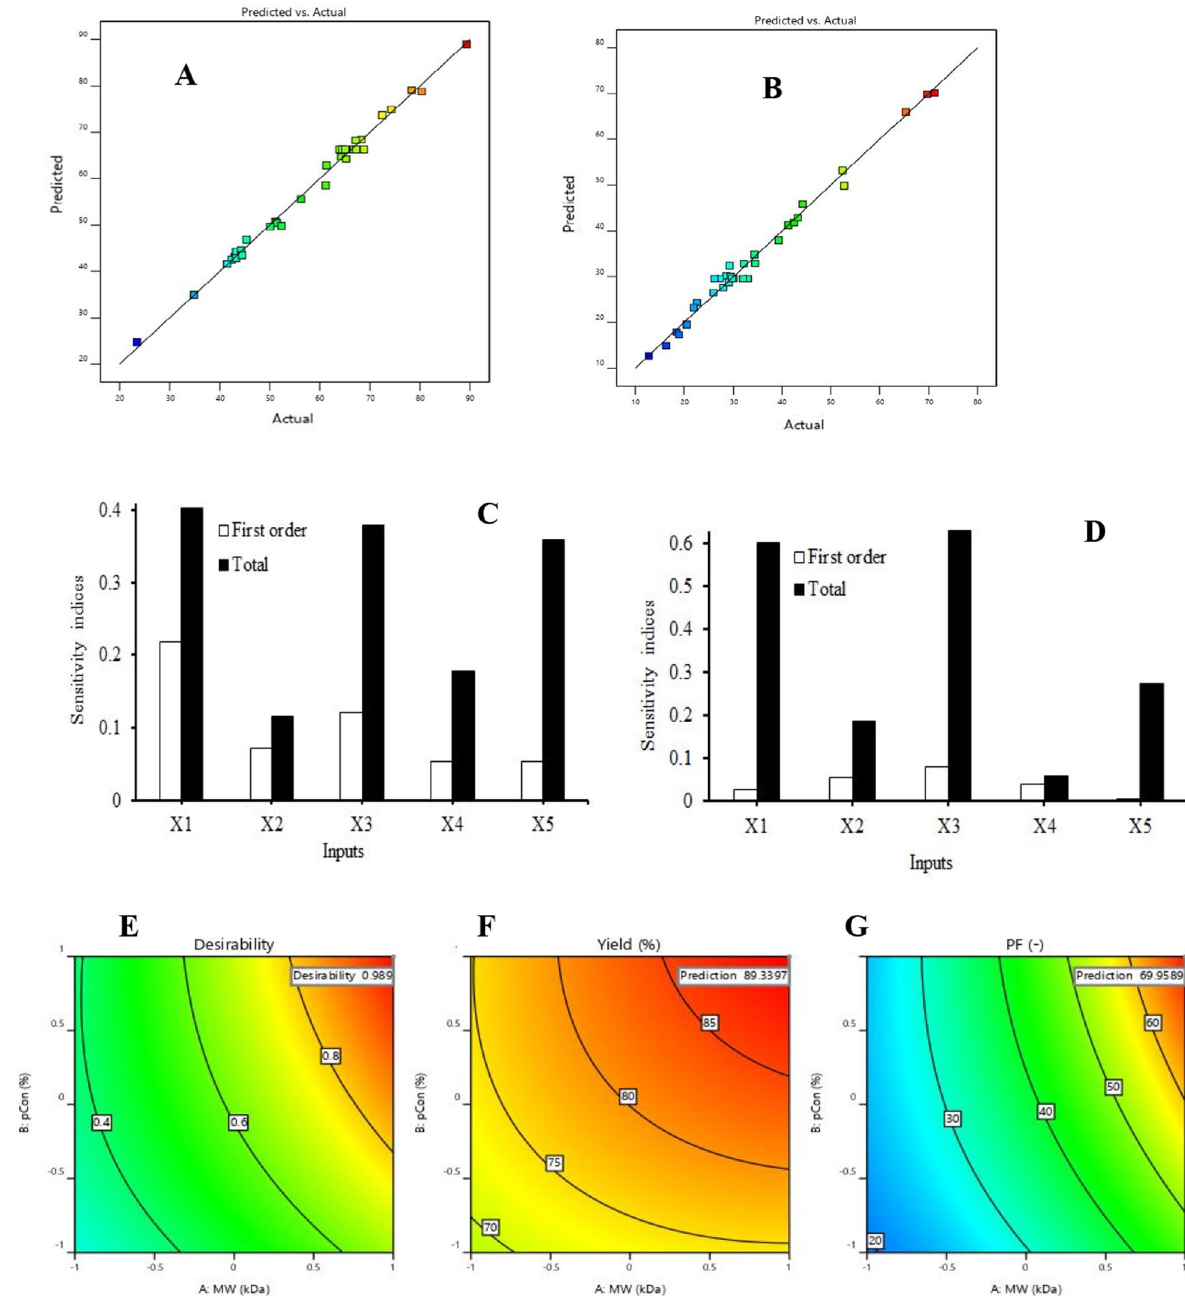
Fig. 2 Multi-objective response surface optimization of conditions for aqueous two-phase system (ATPS) extraction and purification of l -ASNase from fermentation broth: A & B are model performance plots of actual versus predicted yields and purification factors, respectively; C & D are first and total order global sensitivity indices for yield and purification factor, respectively; E is the desirability contour (2D) plot for the multi-objective optimization while F & G are the optimized contour plots for yield and purification factor,